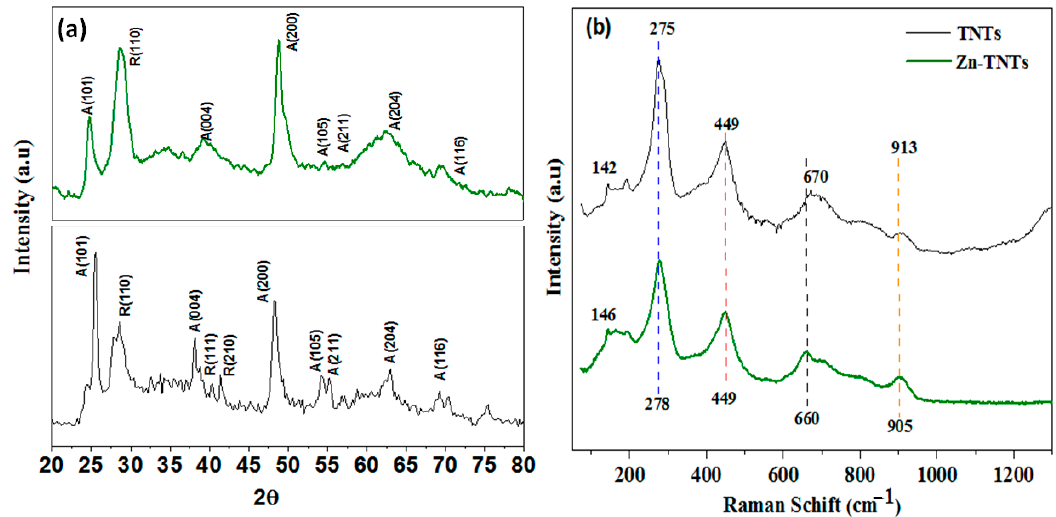
Figure 1. ( a ) XRD patterns and ( b ) Raman spectroscopy of undoped TNTs and Zn-doped TNTs (Zn-TNTs).